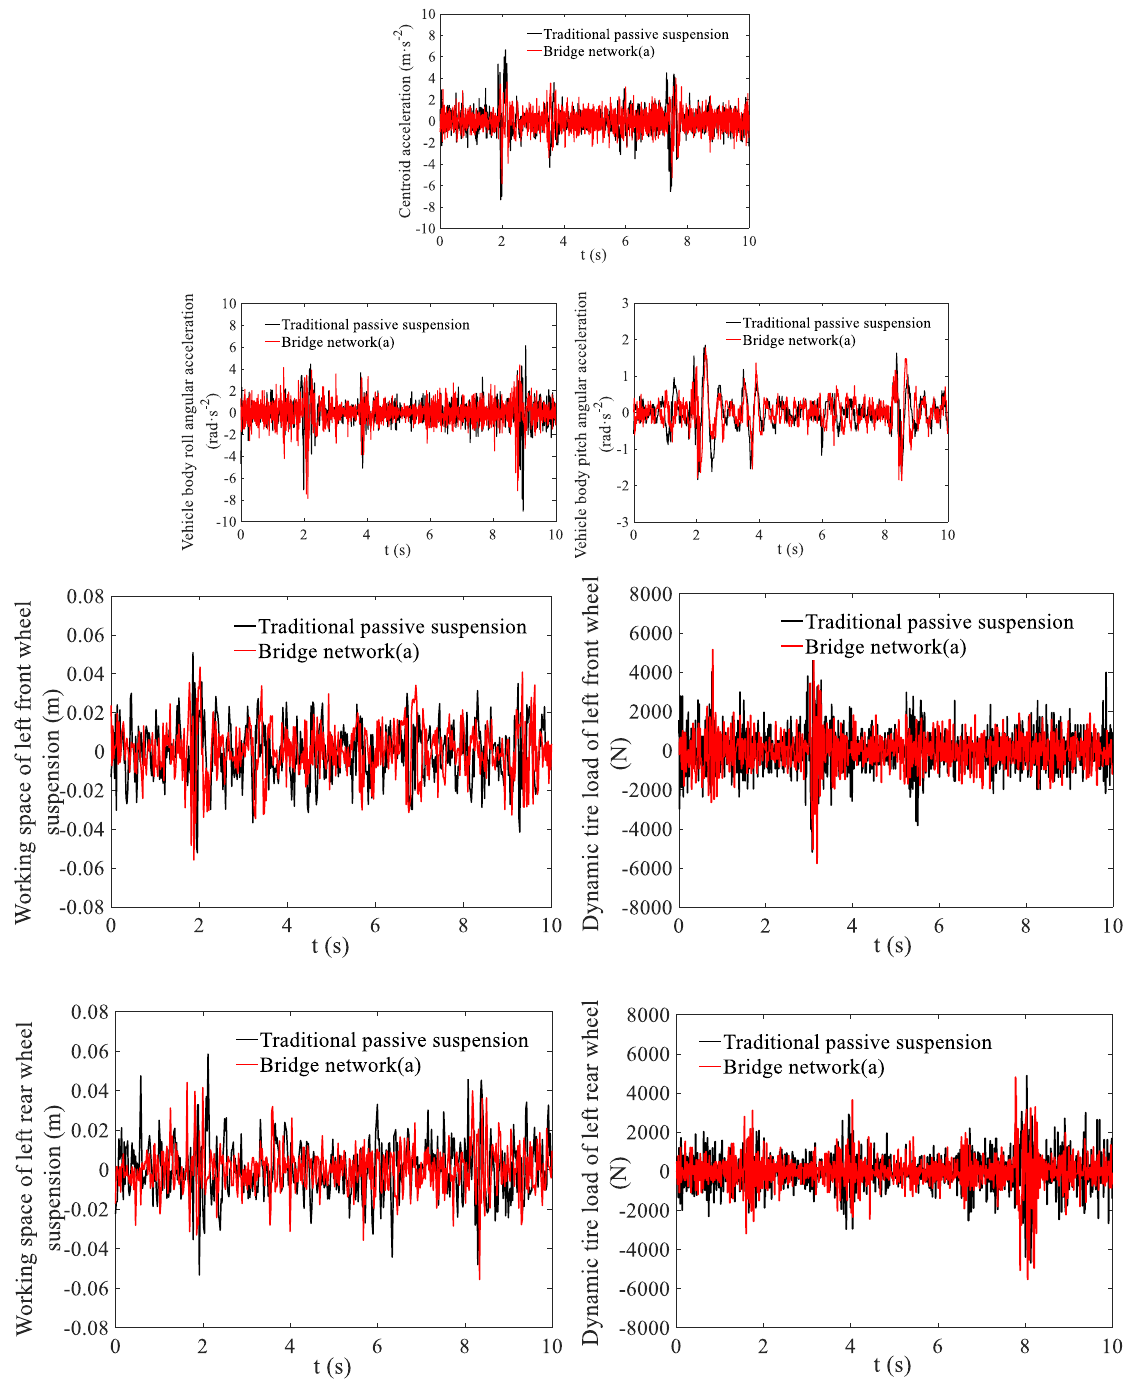
Figure 8. Performance comparison under random road conditions with a vehicle speed of 20 km/h.